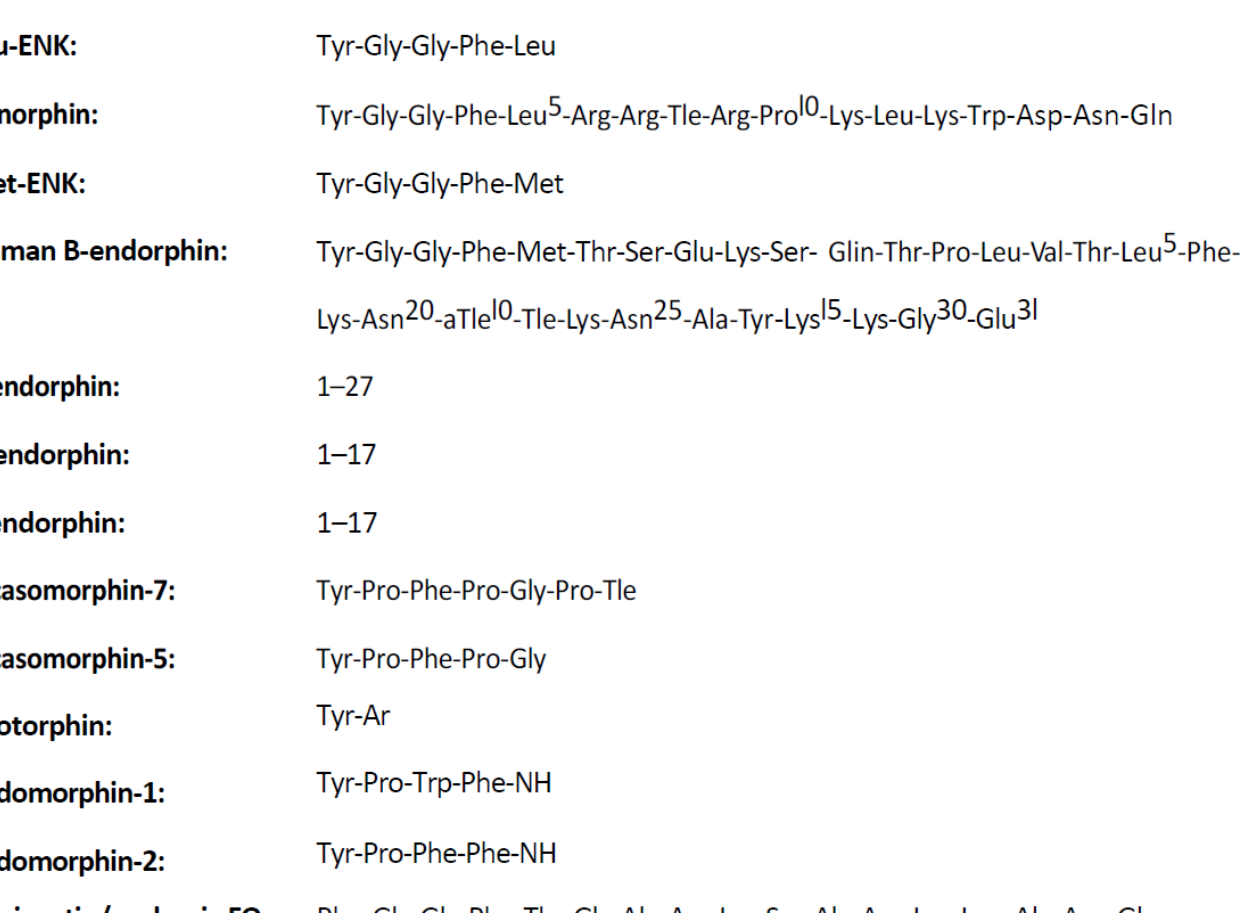
Figure 1. Structure of endogenous opioid peptides (EOPs) [1].